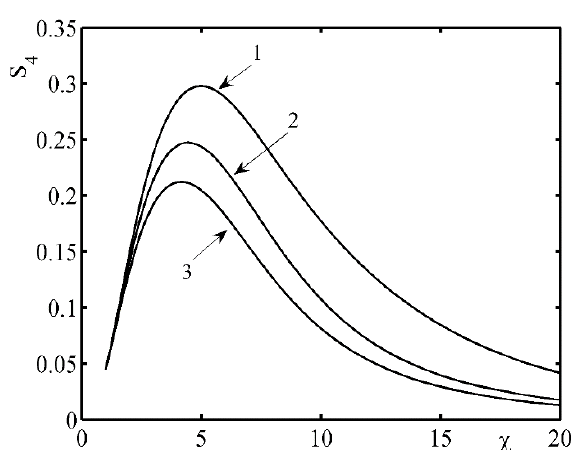
Figure 10: Scintillation index versus anisotropy coefficient for different orientation angle .